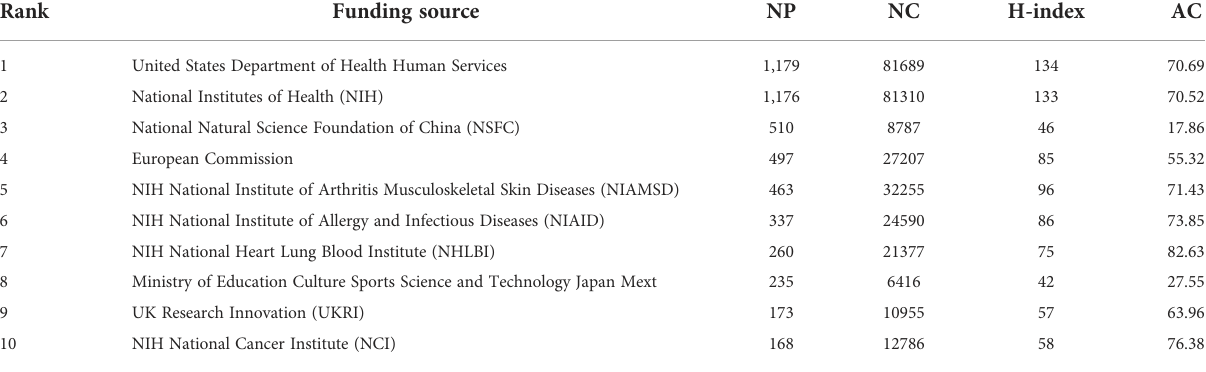
TABLE 3 The top 10 funding source with most publications.